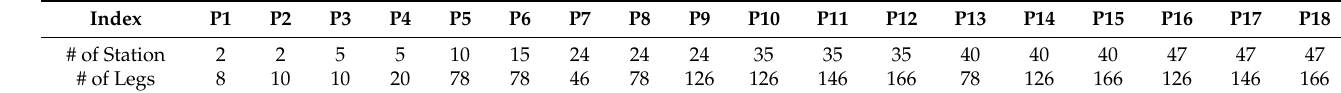
Table 3. Data instances.